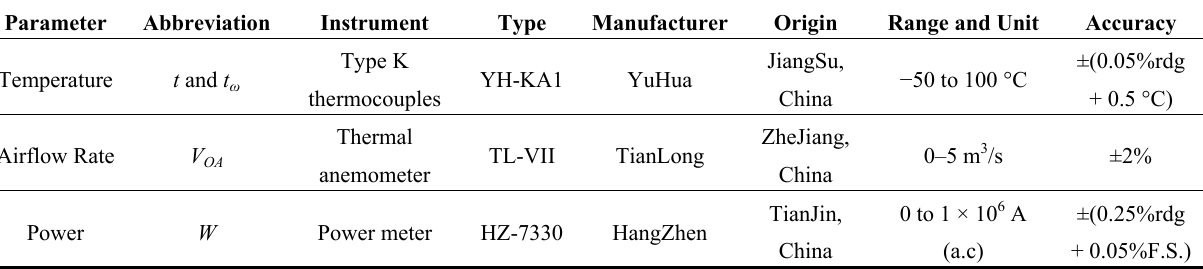
Table 3. Accuracy of major